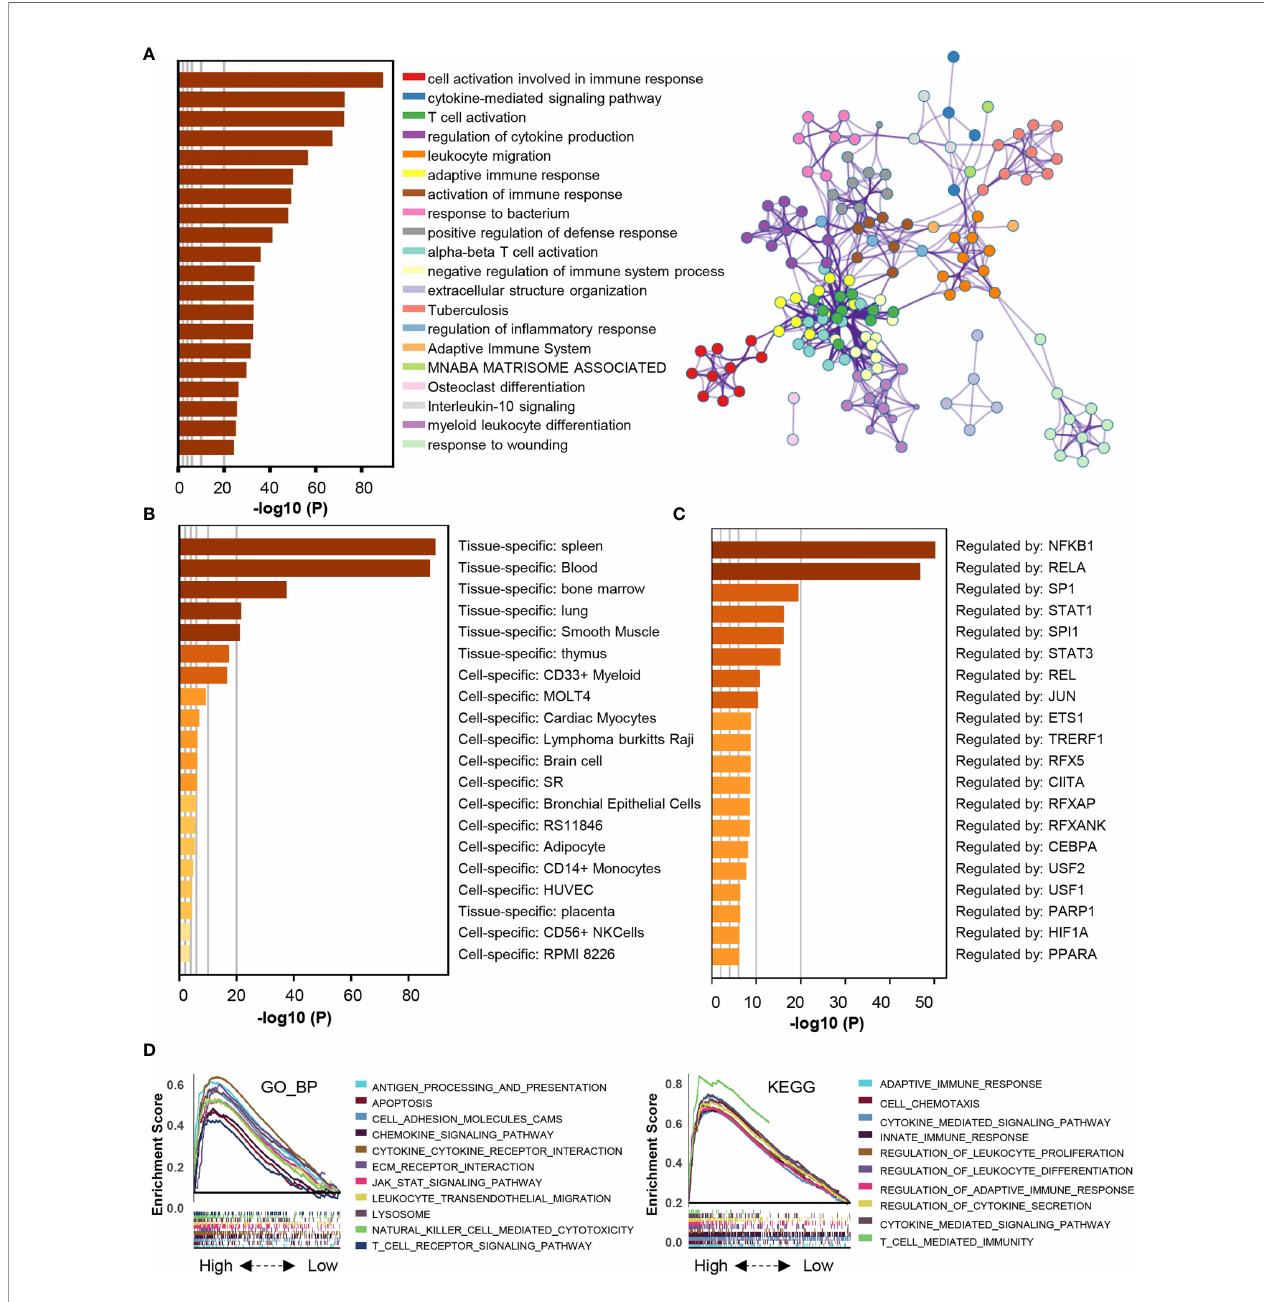
FIGURE 5 | The genes that were positively correlated with HSPA7 were enriched in immune response- and stromal-related pathways. (A) Bar graph of enriched terms, colored by p-values, and corresponding network of enriched terms. (B) Summary of enrichment analysis in PaGenBase and (C) summary of enrichment analysis in TRRUST across HSPA7 positively correlated genes. (D) GSEA analyses displayed key immune-regulated pathways enriched in the high (up) and low (down) HSPA7 groups, both in the GO biological process (left) and KEGG datasets (right), and each line is for one